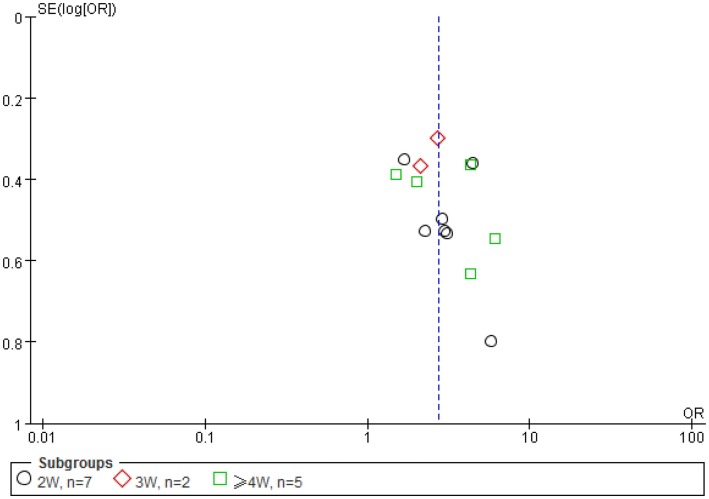
A funnel plot was made using the data of effectiveness rate (ER). A total of 13 trials reported the effect rate, which was categorized into three subgroups by the evaluating time: (1) 7 trials assessed the ER at the end of 2 weeks of treatment, (2) 2 trials assessed the ER at the end of 3 weeks, and (3) 5 trials assessed the ER at the end of 4 weeks. Because of the small number of trials involved, the imperfect or asymmetrical funnel plot is not a reliable indication of potential publication bias in this case.